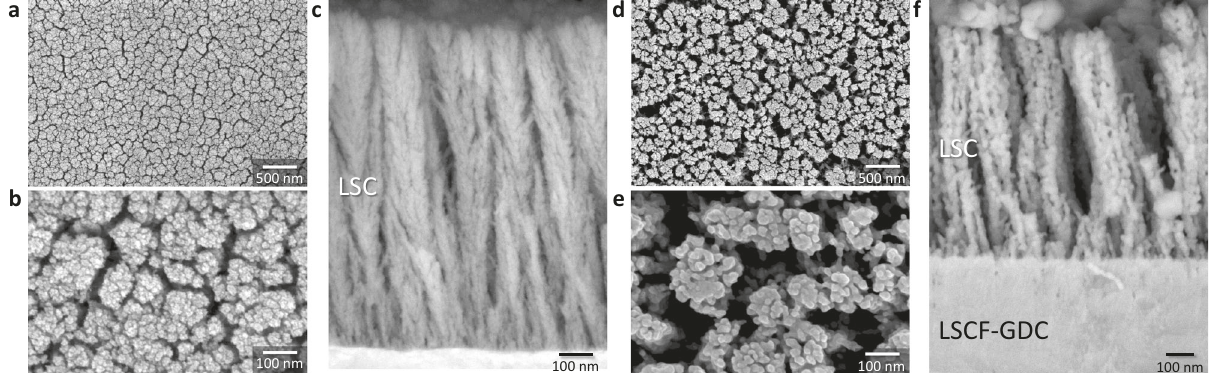
Fig. 3 Microstructural evaluation of the nanoporous LSC thin fi lm. a Representative SEM images depicting a low-magni fi cation view of the surface of the as-grown nanoporous LSC thin fi lm, b corresponding high-magni fi cation view of the surface, and c details of its cross-sectional microstructure. The typical microstructure is comprised of vertically aligned agglomerates separated by nanochannels or nanoporosities. d , e Corresponding SEM images depicting the surface of the nanoporous LSC thin fi lm after annealing at 700 °C in the air for 1 h. f SEM showing the cross-section of the assembled nanoengineered cathode layer comprising the nanoporous LSC thin fi lm on the LSCF-GDC